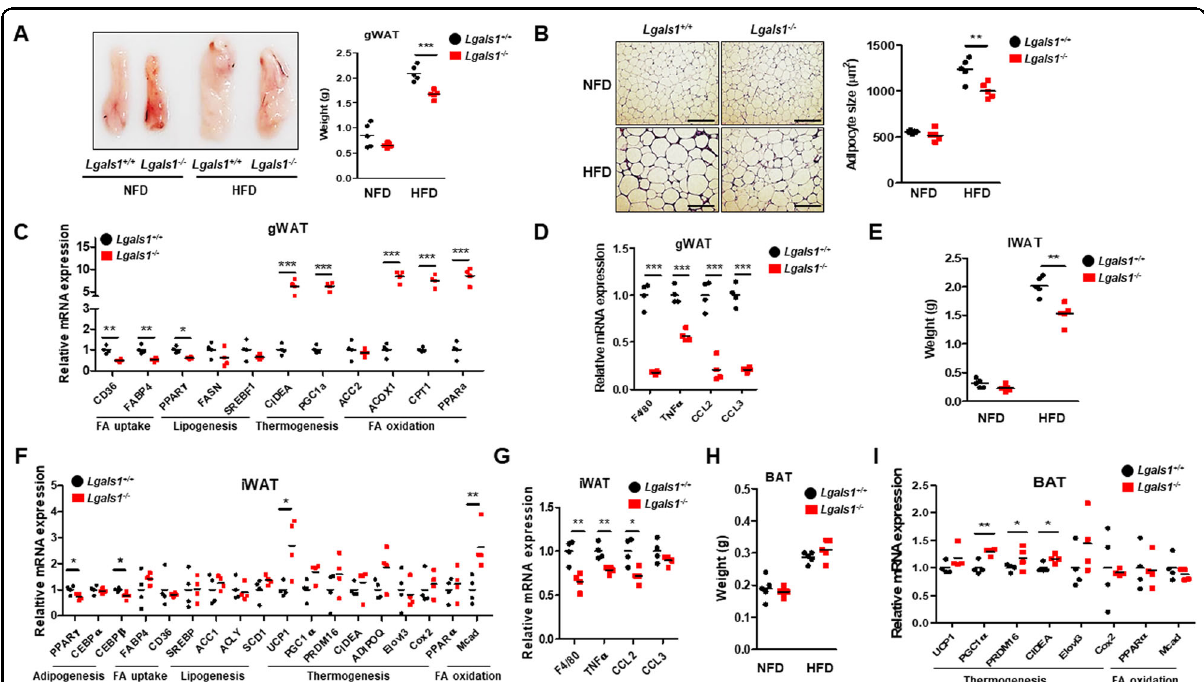
Fig. 5 Lgals1 − / − mice had decreased expression of lipogenic genes and increased expression of thermogenic genes in adipose tissues. Both Lgals1 + / + and Lgals1 − / − mice were fed a NFD or a HFD for 10 weeks ( n = 5 per group) and their gWATs ( a – d ), iWATs ( e – g ) and BATs ( h and i ) were prepared for experiments. a Size and weight of gWATs in Lgals1 + / + and Lgals1 − / − mice fed a NFD or a HFD were measured and presented as a picture and a graph. b Slide sections of gWAT from Lgals1 + / + and Lgals1 − / − mice fed a NFD or a HFD were prepared and stained with H&E. Morphology of adipocytes was presented as a picture. Bars indicated 100 μ m. Size of adipocytes was measured using Image J software and presented as a graph. c The expression of genes involved in fatty acid uptake, such as CD36 and FABP4, in lipogenesis, such as PPAR γ , FASN, SREBF1, in thermogenesis, such as CIDEA and PGC1 α , and in fatty acid oxidation, such as ACOX1, CPT1 and PPAR α in gWATs from Lgals1 + / + and Lgals1 − / − mice fed a HFD was analyzed by quantitative RT-PCR. d The expression of genes, included F4/80, a macrophage marker and pro-in fl ammatory cytokines, such as TNF α , CCL2 and CCL3 in gWATs from Lgals1 + / + and Lgals1 − / − mice fed a HFD was analyzed by quantitative RT-PCR. Data are presented as the mean ± SEM *** p < 0.001 for the Lgals1 + / + mice vs. the Lgals1 − / − mice. e Weight of iWATs in Lgals1 + / + and Lgals1 − / − mice fed a NFD or a HFD was measured and presented as a graph. f The expression of genes involved in adipogenesis, such as PPAR γ , CEBP α and CEBP β , in fatty acid uptake, such as CD36 and FABP4, in lipogenesis, such as SREBP, ACC1, ACLY and SCD1, in thermogenesis, such as UCP1, PGC1 α , PRDM16, CIDEA, ADIPOQ, Elovl3 and COX2, and in fatty acid oxidation, such as PPAR α and Mcad in iWATs from Lgals1 + / + and Lgals1 − / − mice fed a HFD was analyzed by quantitative RT-PCR. g The expression of genes, included F4/80, TNF α , CCL2 and CCL3 in iWATs from Lgals1 + / + and Lgals1 − / − mice fed a HFD was analyzed by quantitative RT-PCR. Data are presented as the mean ± SEM * p < 0.05 and ** p < 0.01 for the Lgals1 + / + mice vs. the Lgals1 − / − mice. h Weight of BATs in Lgals1 + / + and Lgals1 − / − mice fed a NFD or a HFD were measured and presented as a graph. i The expression of genes involved in thermogenesis, such as UCP1, PGC1 α , PRDM16, CIDEA, Elovl3 and COX2, and in fatty acid oxidation, such as PPAR α and Mcad in iBATs from Lgals1 + / + and Lgals1 − / − mice fed a HFD was analyzed by quantitative RT-PCR. Data are presented as the mean ± SEM * p < 0.05 and ** p < 0.01 for the Lgals1 + / + mice vs. the Lgals1 − / −